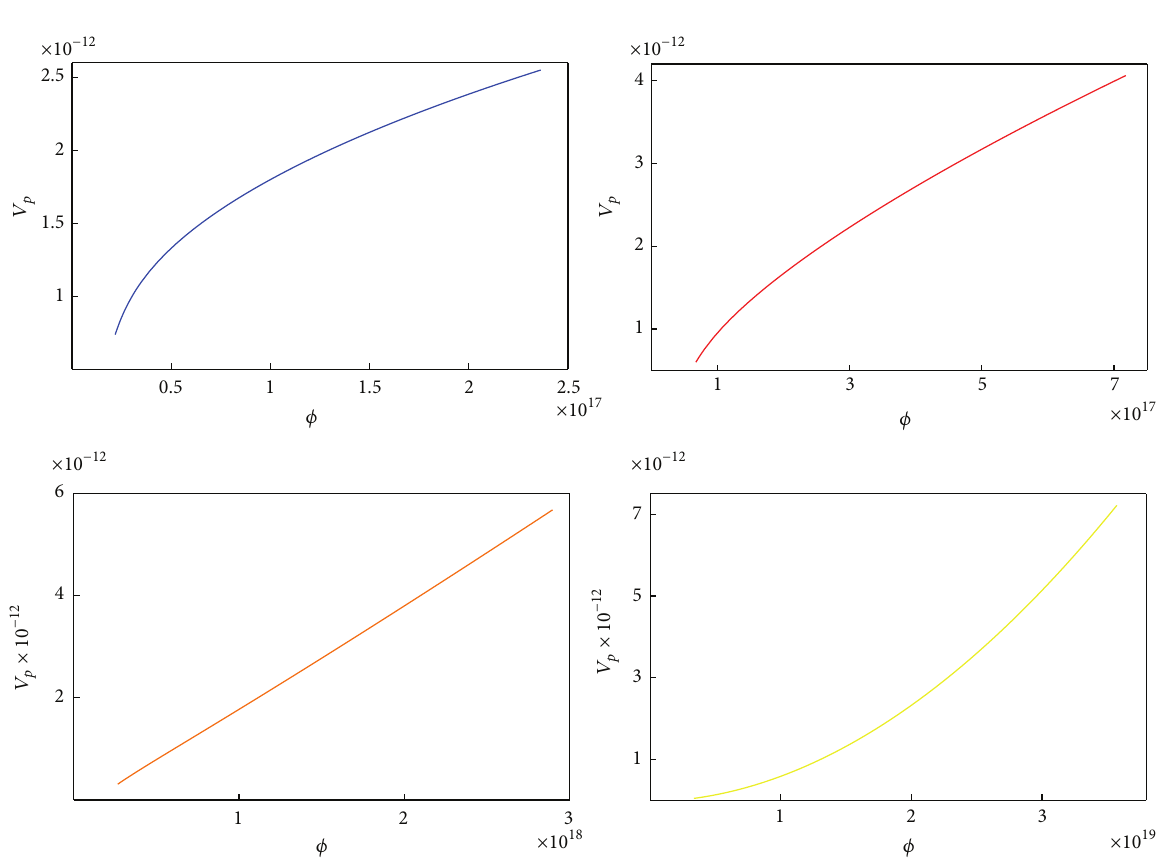
Figure 6: The potential behavior has been portrayed for different values of tensor-to-scalar ratio as: 𝑟 = 0 . 05 (blue), 𝑟 = 0 . 08 (red), 𝑟 = 0 . 11 (orange), and 𝑟 = 0 . 14